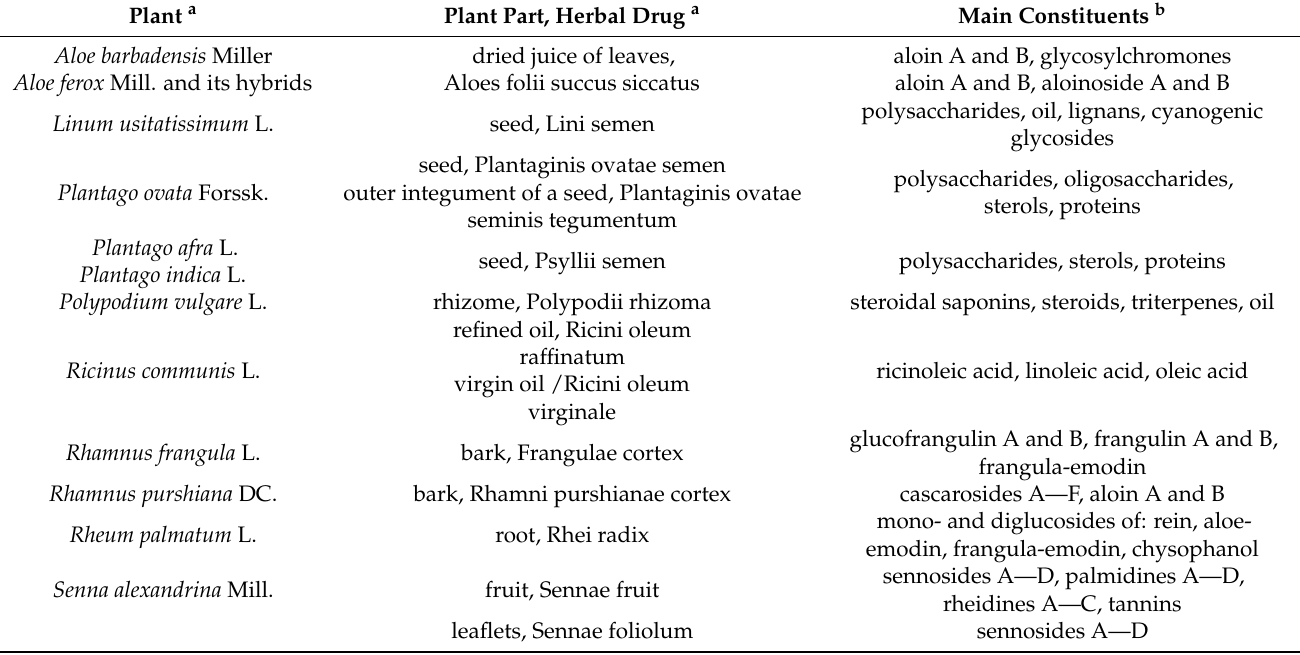
Table 5. Herbal drugs used in functional constipation [47]. Plant a Plant Part, Herbal Drug a Main Constituents